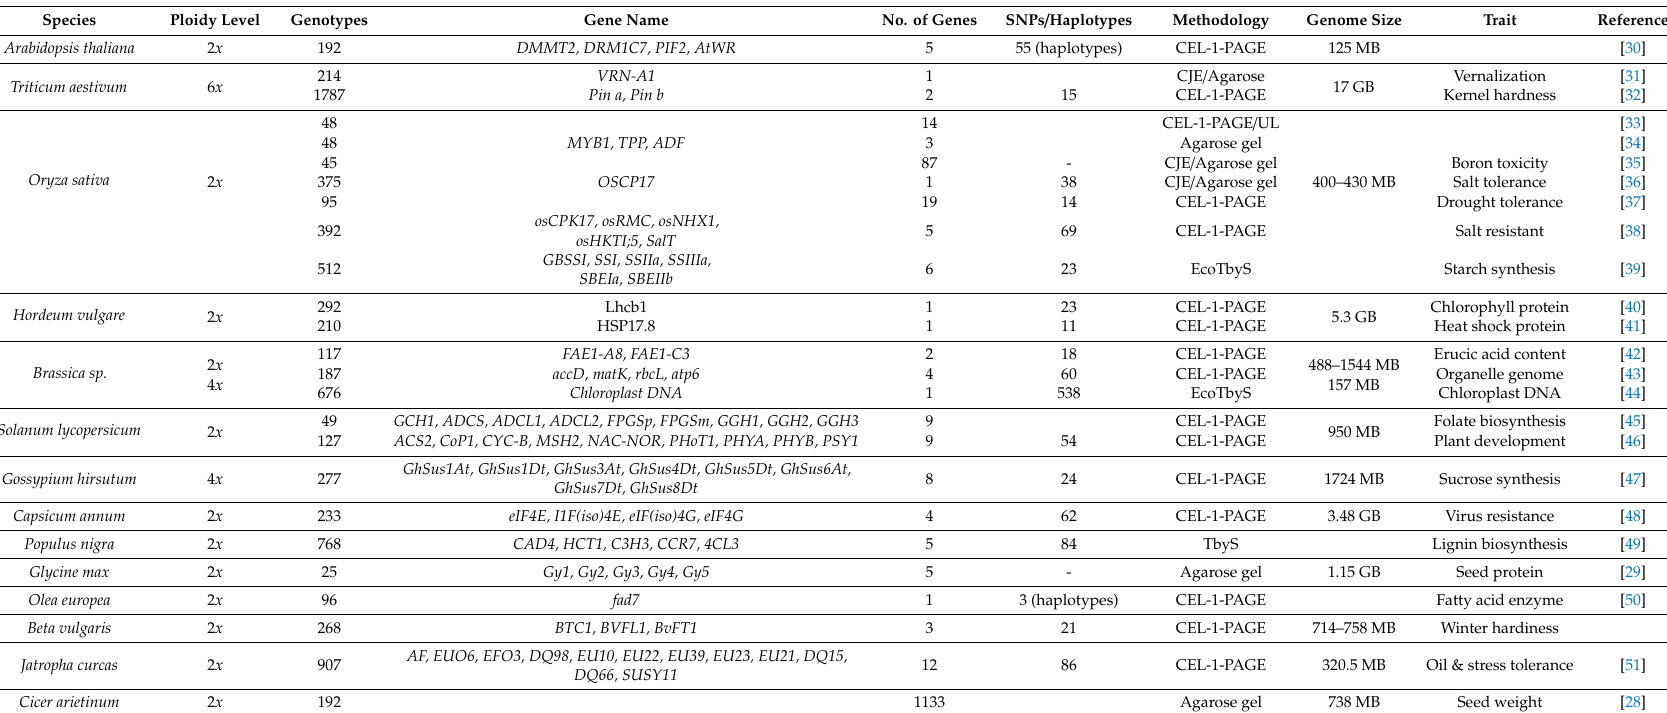
Table 1. Identification of natural polymorphism of target genes in di ff erent crops using